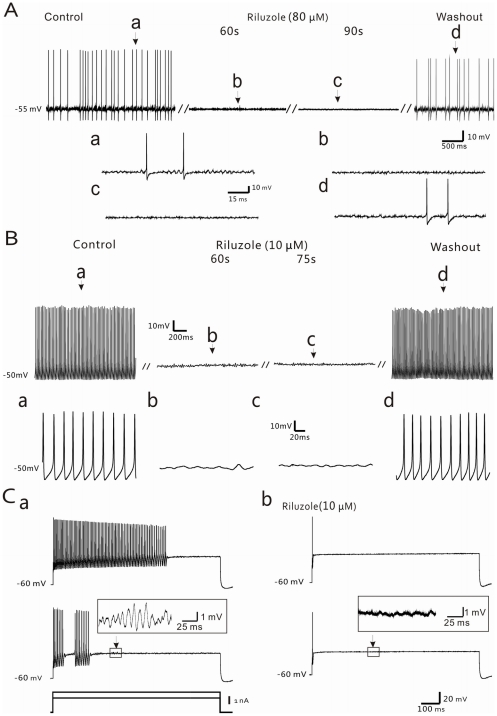
Effects of riluzole on the spontaneous activity and SMPOs of A-type neurons in the compressed DRG.(A) Intracellullar sharp electrode recordings from an A-type DRG neuron in vivo, showing spontaneous activity and SMPOs under control conditions (a), after local application of riluzole (80 µM; b,c), and during washout (d). The spikes have been truncated. Inserted segments (a–d, lower panel) are expansions of the original traces at the times indicated and show details of the spikes and SMPOs. (B) Whole-cell patch recordings from an A-type DRG neuron in vitro. Spontaneous activity (a) was significantly inhibited in the presence of riluzole (10 µM; b,c) and restored after washout (d). The spikes have been truncated. Inserted segments (a–d, lower panel) are expansions of the original traces at the times indicated. (C) Whole-cell patch recordings from an A-type DRG neuron in vitro. (a) The cell responded to depolarizing current pulses of 1.7 nA (upper panel) and 2.4 nA (lower panel) with repetitive firing and SMPOs (insertion). (b) In the presence of 10 µM riluzole (upper panel), both the repetitive firing and SMPOs (insertion) induced by depolarization were abolished; however, a single action potential was still evoked immediately after application of the current pulse.